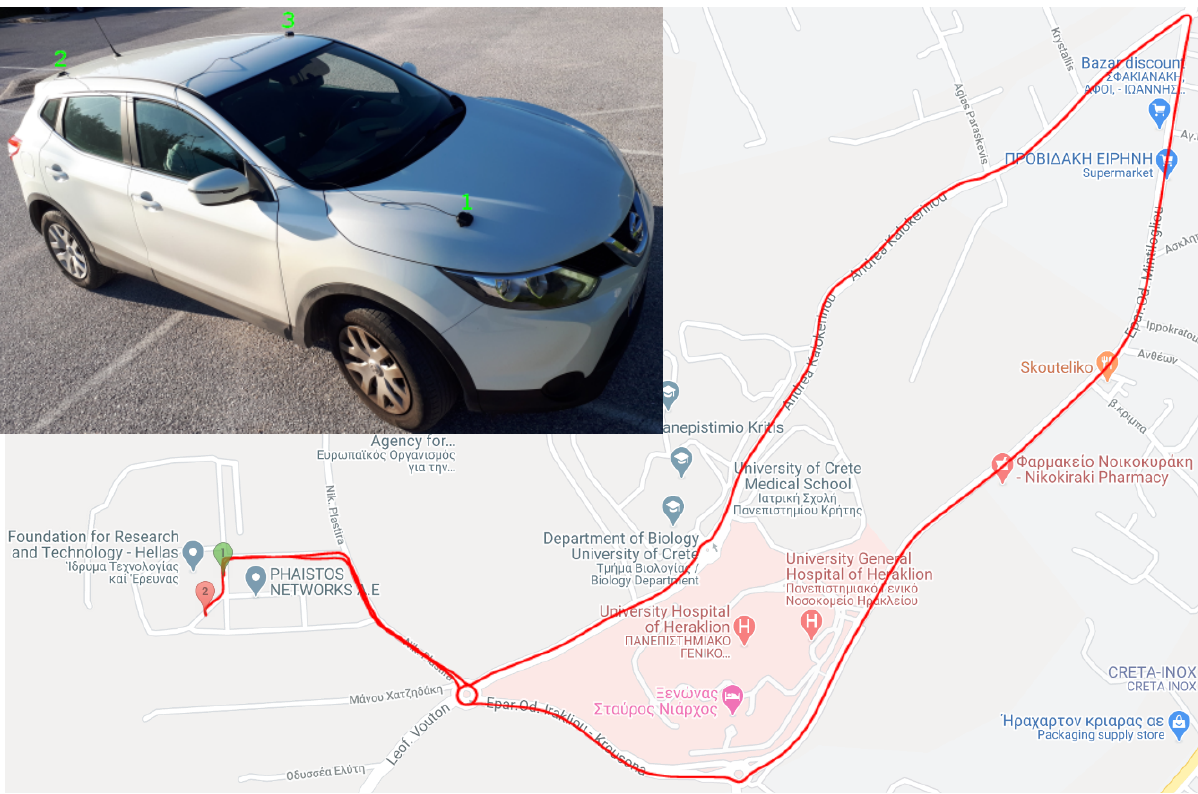
Figure 1. Closed route traversed in a counterclockwise direction overlaid on a Google street map. Start and end points are indicated with green and red pins, respectively. The inset image shows the antennas of the three u-blox receivers attached on the car used. The surveyed HGRS87 coordinates of the junction GCPs